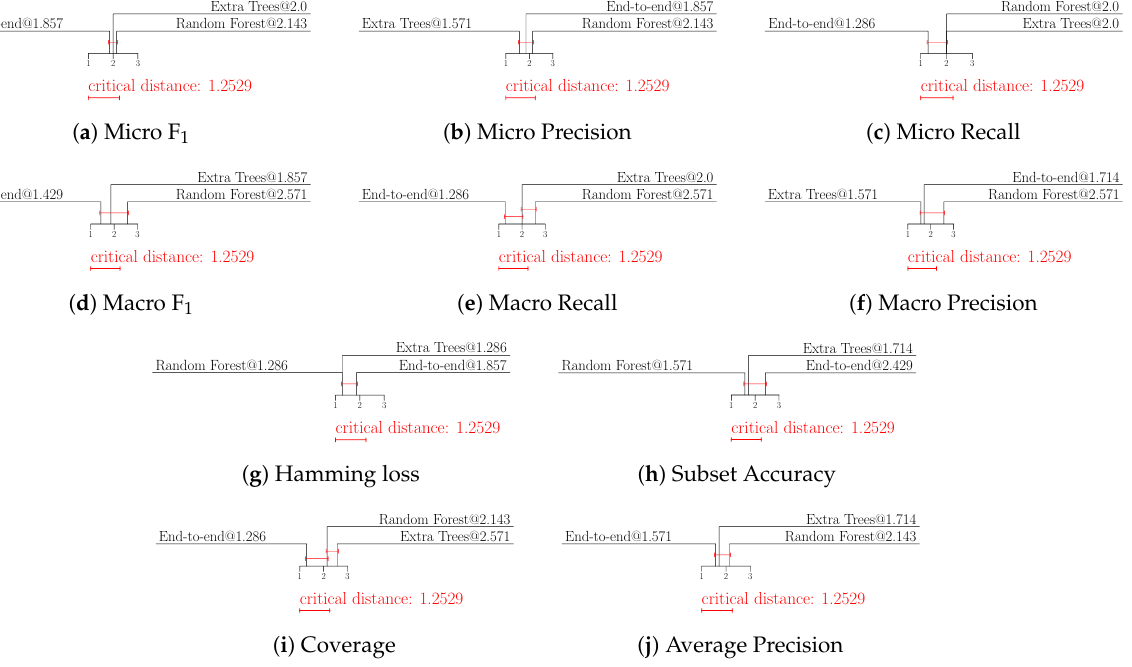
Figure A7. Performance of different learning methods in terms of all MLC evaluation measures for fine-tuned features. The results are presented in the form of average rank diagrams at a 0.05 significance level. The best ranking methods are at the left-most side of the diagram. The difference among the methods connected with a red line is not statistically